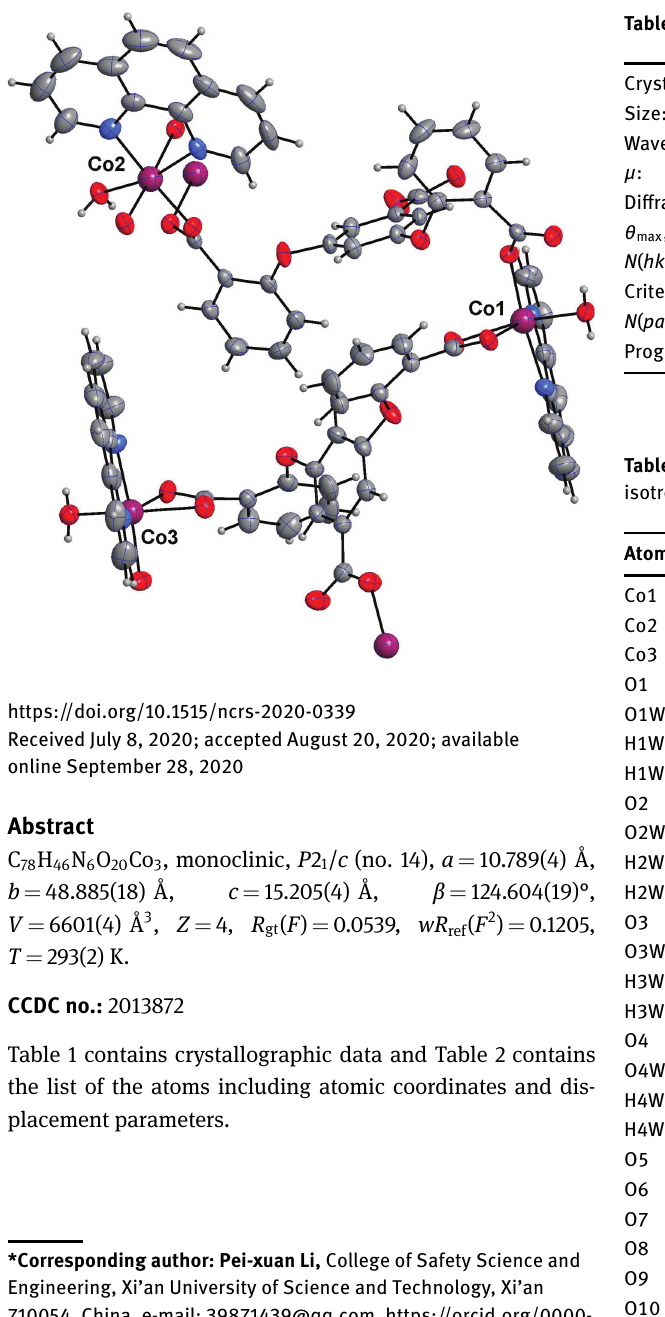
Table 1 contains crystallographic data and Table 2 contains the list of the atoms including atomic coordinates and dis- placement parameters.